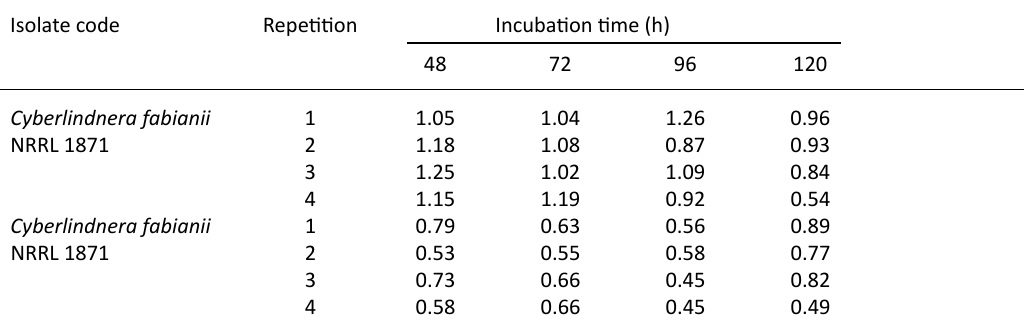
table 4. Amylase activity value of Cyberlindnera fabianii NRRL 1871 and Candida sorboxylosa ADR2-2 at pH 4 in Solid State Fermentation method Isolate code